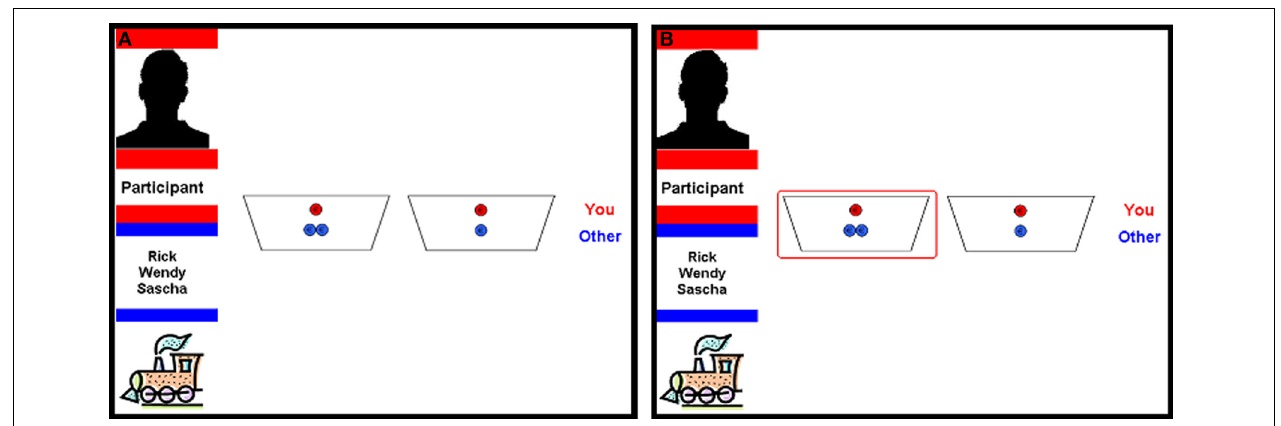
FIGURE 1 | Visual display for the allocation games. (A) Two offers, each containing red and blue coins, indicate the share for the proposer and the interaction partner, respectively (here depicted Disadvantageous prosocial game 1/2 vs. 1/1). The left top panel displays the name of the proposer in red